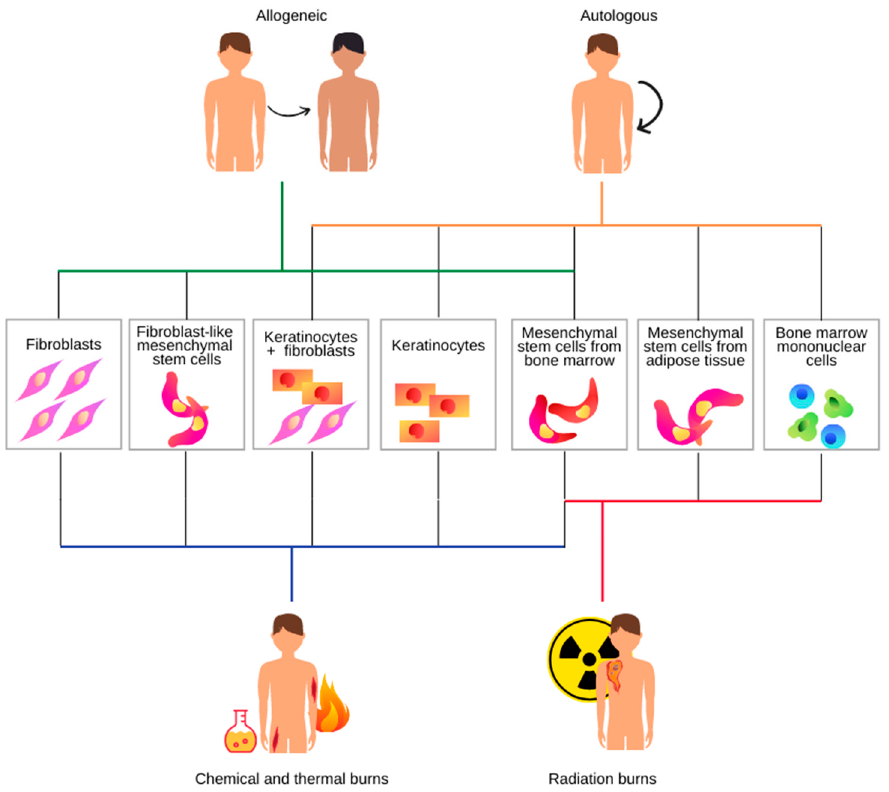
Figure 1. Cell therapy strategies for burn wound healing.